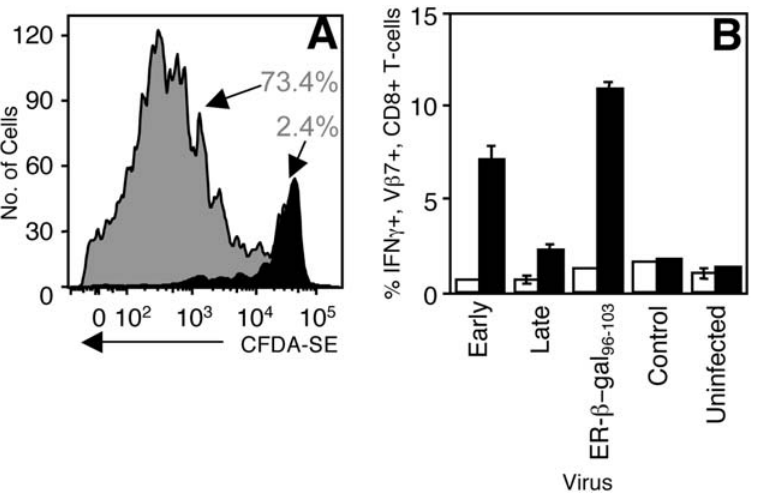
Figure 1. Late VACV promoter-driven antigen does not elicit a T CD8 + response. In vivo proliferation (A) or ex vivo effector function (B) of adoptively transferred b -gal specific BG1 TCR transgenic T CD8 + was examined in response to immunization with rVACV- b -gal-Early [(A), gray] or rVACV- b -gal-Late [(A), black] or as shown (B). Proliferation was measured by dilution of CFDA-SE (A) and numbers shown represent the percentage of cells that have diluted the dye 2 days after immunization. Ex vivo effector function (B) was measured by quantifying production of IFN- c in the presence (black) or absence (white) of b -gal 96–103 peptide.